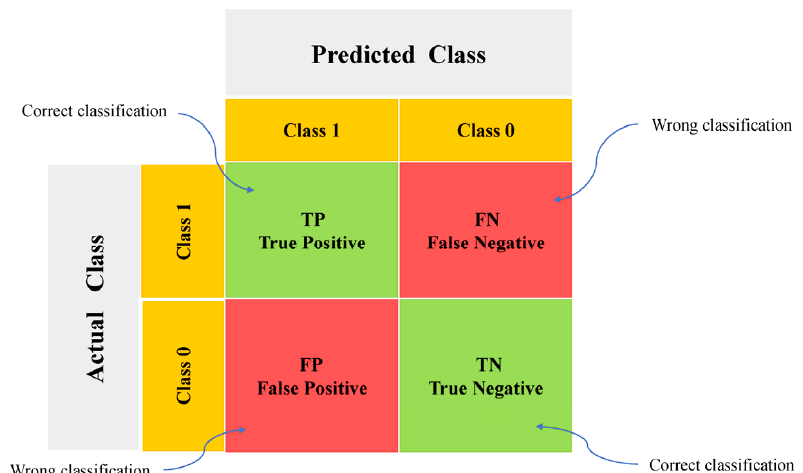
Figure 6. Confusion matrix.